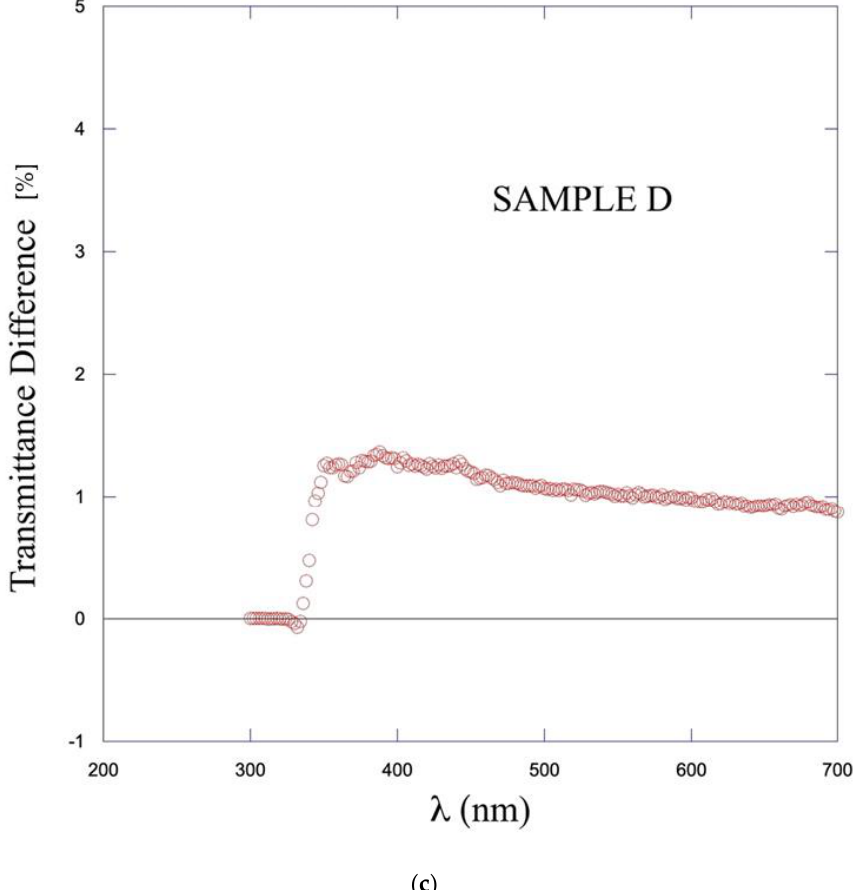
Figure 8. The difference of the transmittance percentage value after and before the treatment is showed in the graphs. The increment is higher for the sample C. The lowest values are for the sample D. The recovery for the all the samples seems to have the same behaviour, affecting more to short wavelength. This would be more in line with a possible radiation damage recovery.